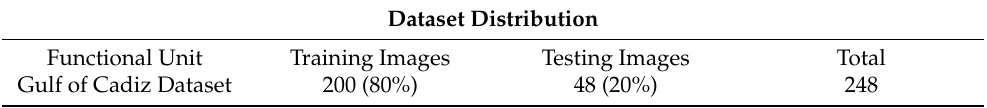
Table 2. Dataset